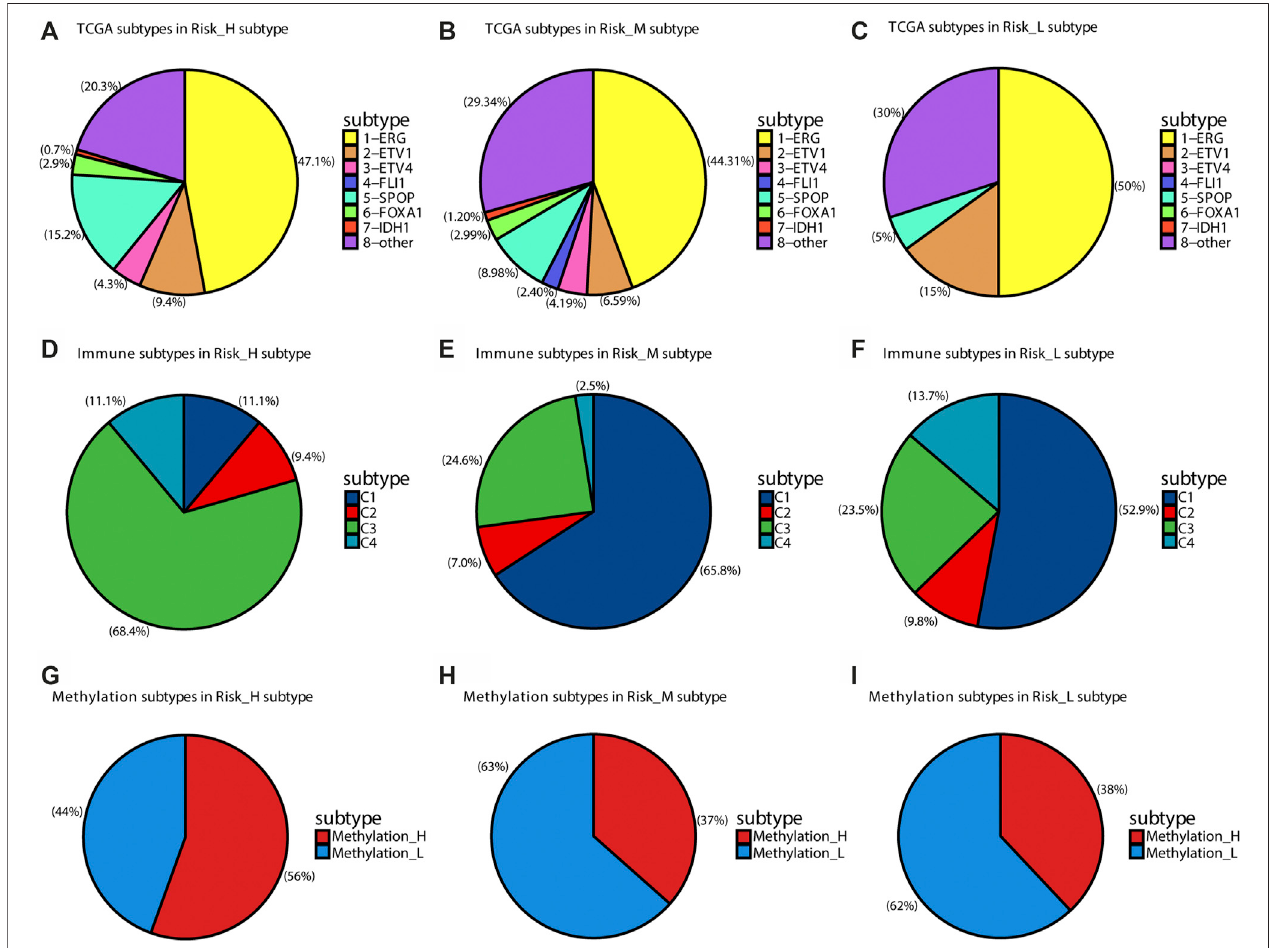
FIGURE 3 | The distribution of other TCGA subtypes in subtypes of this research. (A) The distribution of TCGA subtypes in Risk_H subtype. (B) The distribution of TCGA subtypes in Risk_M subtype. (C) The distribution of TCGA subtypes in Risk_L subtype. (D) The distribution of immune subtypes in Risk_H subtype. (E) The distribution of immune subtypes in Risk_M subtype. (F) The distribution of immune subtypes in Risk_L subtype. (G) The distribution of DNA methylation subtypes in Risk_H subtype. (H) The distribution of DNA methylation subtypes in Risk_M subtype. (I) The distribution of DNA methylation subtypes in Risk_L